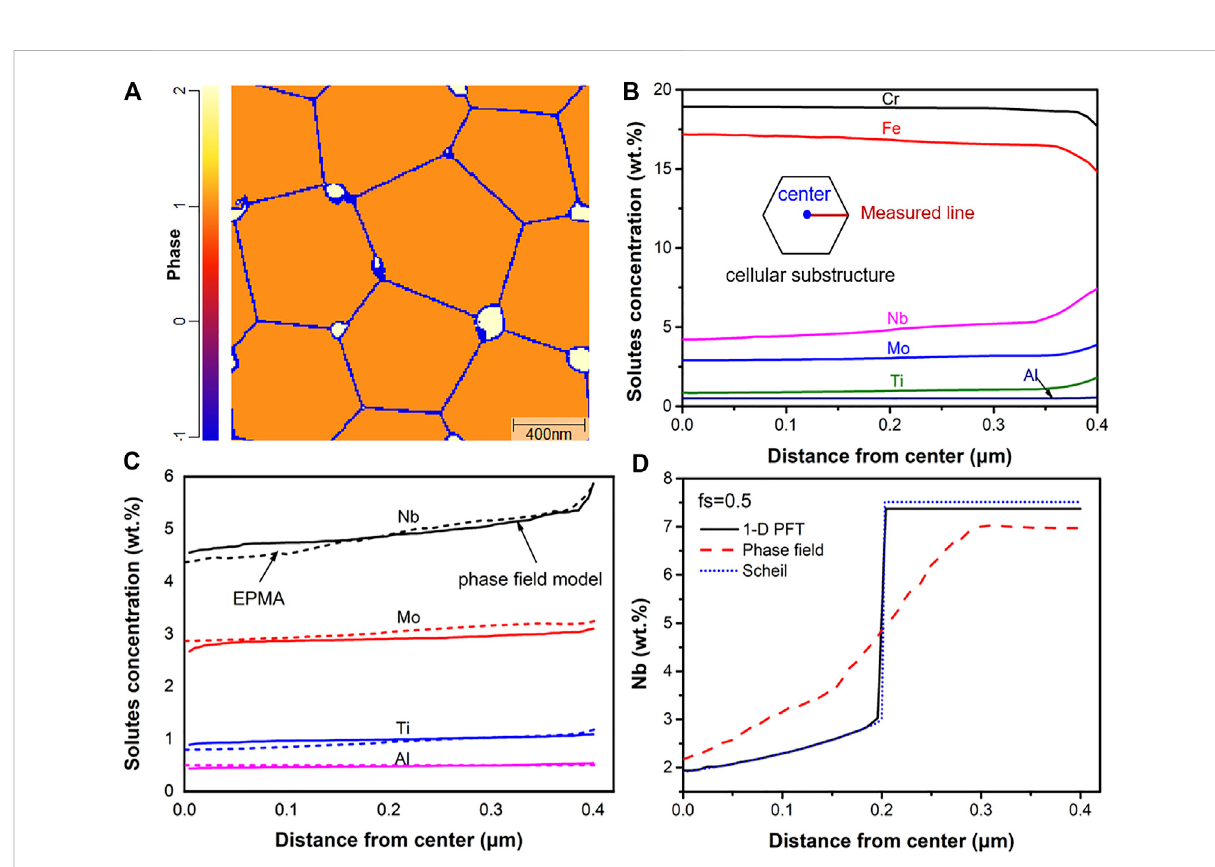
FIGURE 3 Simulation results of (A) cellular substructure and Laves phase distribution, (B) solute distribution curves from center to edge in cellular substructure.Solutesdistributioncurves, (C) EPMAmeasurementsandmultiphase- fi eldmodelsimulationresults, (D) Nbdistributioncalculatedby1- D PFT model, multiphase- fi eld model, and Scheil model when fs =